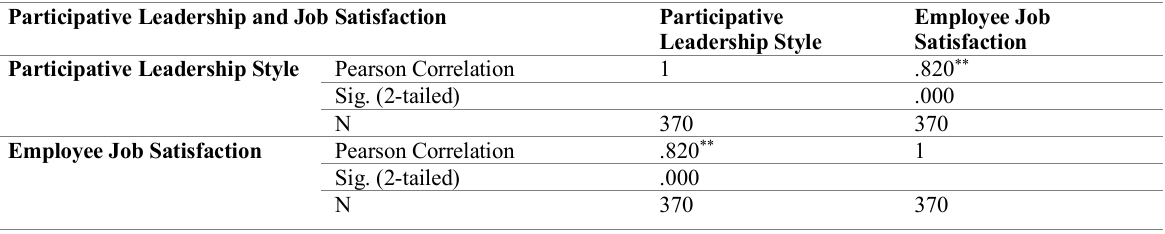
Table 2: Correlation test for participative leadership